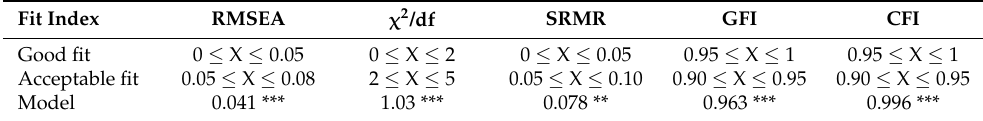
Table 3. Model fit indices.